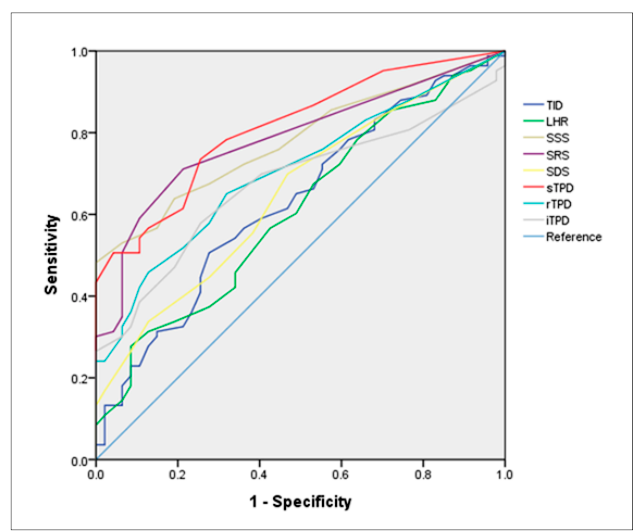
Figure 2. The receiver operating characteristic (ROC) curves for semi-quantitative parameters derived from myocardial perfusion imaging correlated with coronary artery diseases. rTPD: resting total perfusion deficit; iTPD: ischemic total perfusion deficit. Table 2. The ideal cutoff values using ROC curve analysis for distinguishing the semi-quantitative parameters of myocardial perfusion imaging correlated with coronary artery disease.